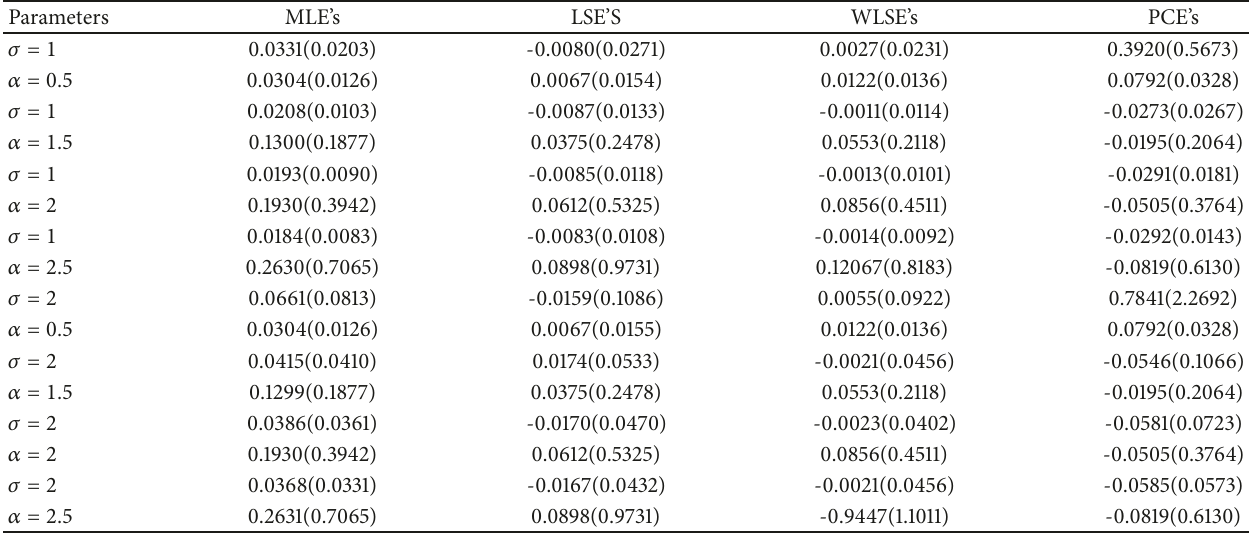
Table 2: Average bias values of estimates and their MSE (in brackets) when